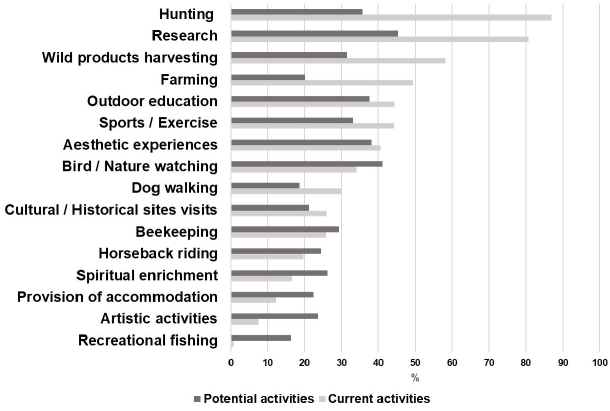
Fig. 2 . Percentage of respondents indicating current and potential cultural ecosystem services